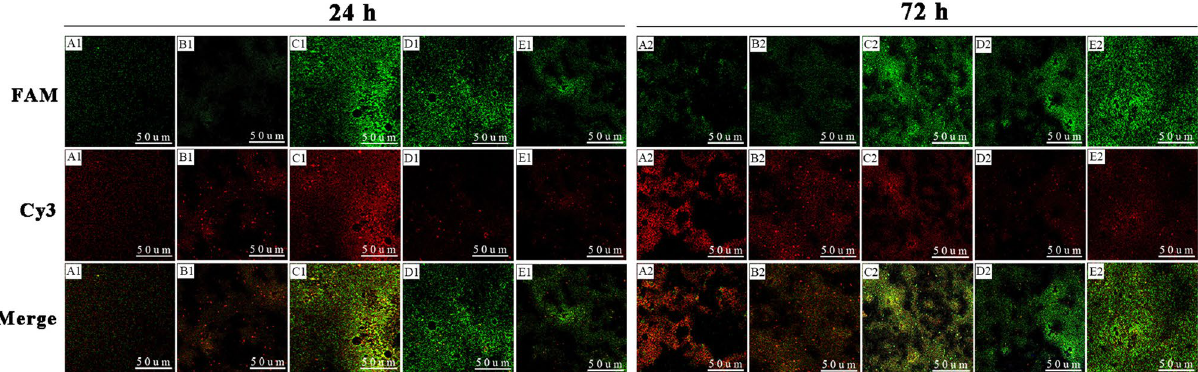
Figure 4. Observation of the composition of mixed-species BFs by FISH-CLSM at 24 h and 72 h. The images were obtained at × 200 magnification. ( A1 ) Control group (24 h); ( B1 ) 5% lipid emulsion group (24 h); ( C1 ) 10% lipid emulsion group (24 h); ( D1 ) 15% lipid emulsion group (24 h); ( E1 ) 20% lipid emulsion group (24 h); ( A2 ) control group (72 h); ( B2 ) 5% lipid emulsion group (72 h); ( C2 ) 10% lipid emulsion group (72 h); ( D2 )